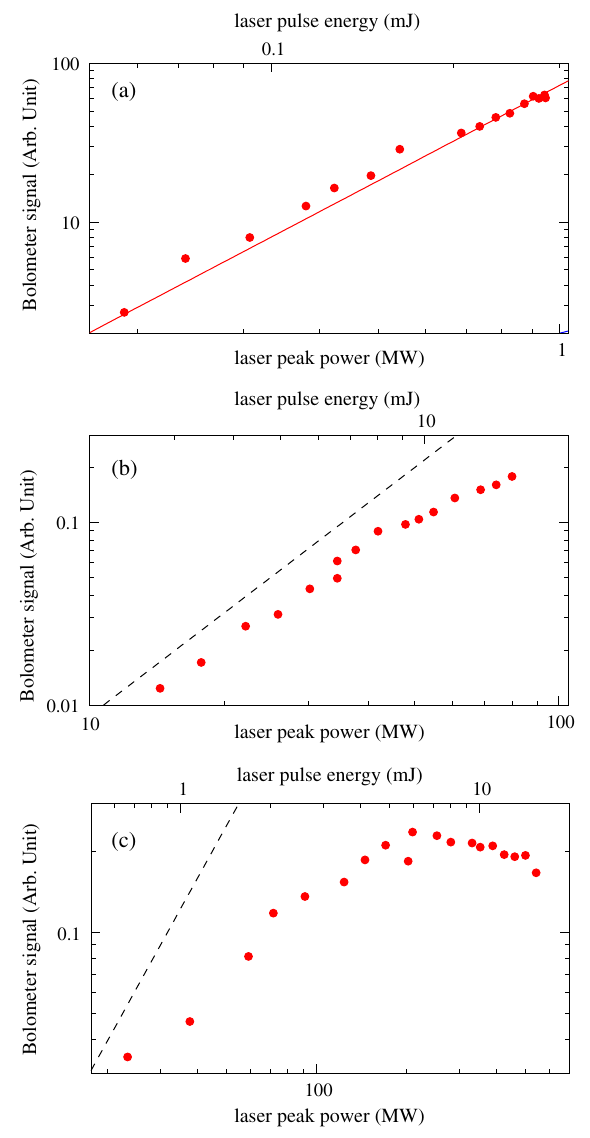
FIG. 4. Typical scalings of terahertz signal versus laser power for three power ranges: (a) reference quasiquadratic behavior that was already observed at low power, with a 2 mJ amplifier and 300 ps long-pulses (the dots and the full line represent respectively the experimental data and a quadratic fit); (b) and (c) behaviors obtained with the current 70 mJ amplifier and shorter pulses: 191 ps FWHM (b) and 28.5 ps (c). The dashed lines represent a reference quadratic slope. Modulation period is identical ( (cid:1) 2 : 4 ps , i.e., 14 cm (cid:2) 1 ) for each recording. Note that electron bunch duration is (cid:1) 240 ps FWHM (length 3.1 cm